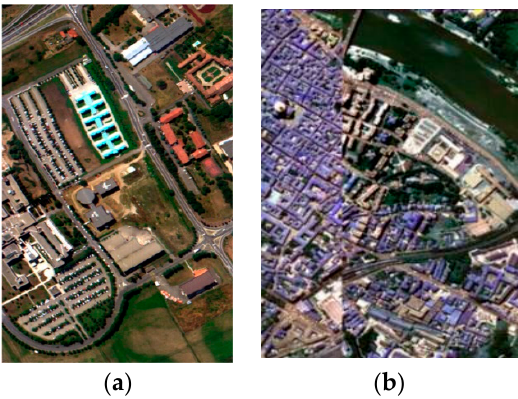
Figure 5. Hyperspectral images (HSIs) of Pavia city. ( a ) PaviaU HSI. ( b ) PaviaC HSI.